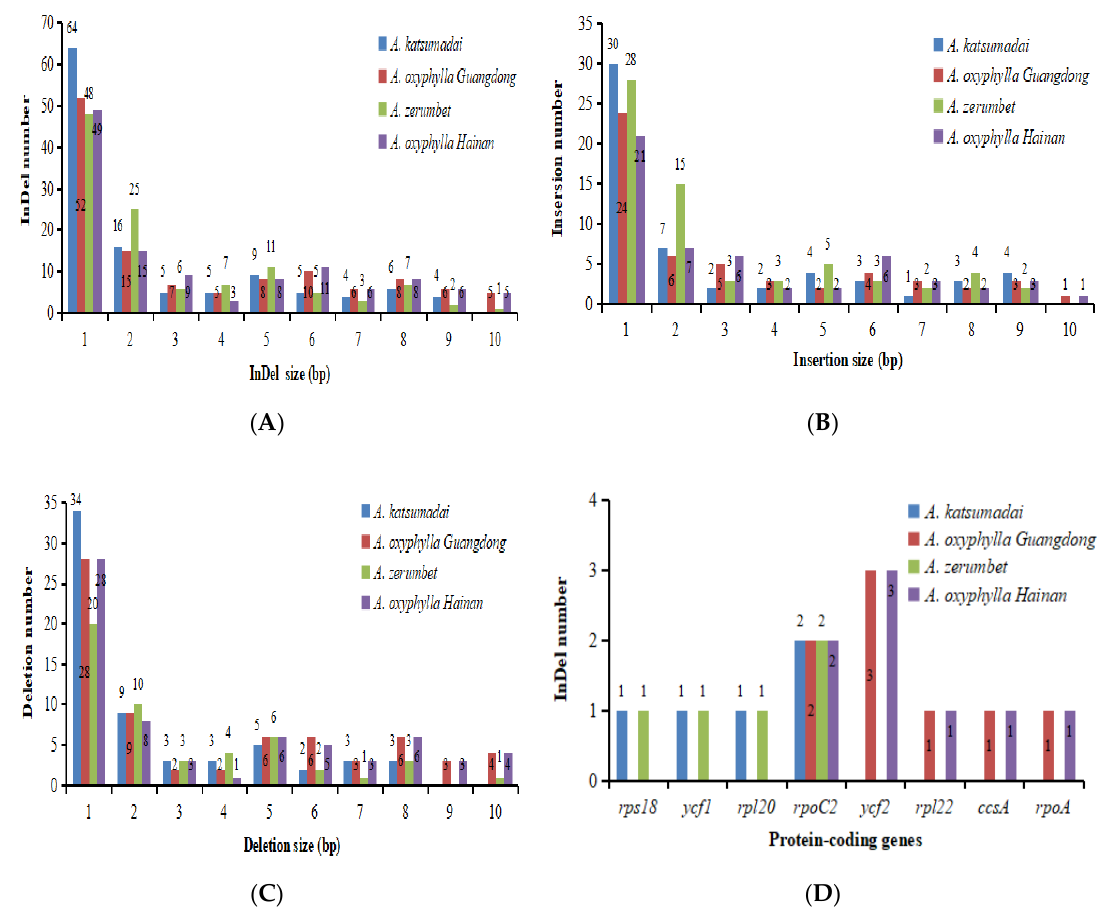
Figure 8. Indels statistics of four Alpinia chloroplast genomes. The A. pumila chloroplast genome was used as the reference sequence for indels analyses for the other four chloroplast genomes. ( A ) Total indels statistics. ( B ) Insertion statistics. ( C ) Deletion statistics. ( D ) Indels belonging to different protein-coding genes.